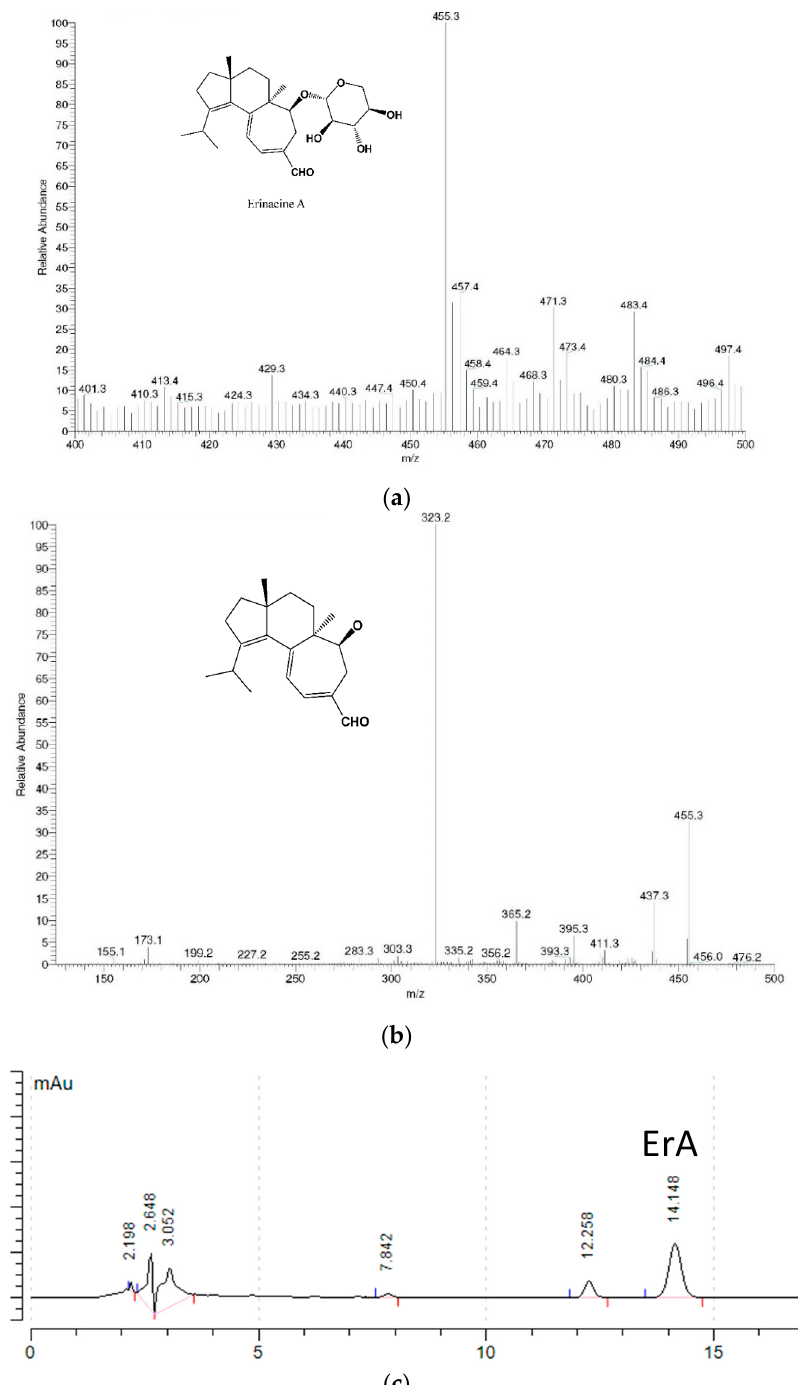
Figure 7. Analysis and identification of ErA using: ( a ) ESI Mass for ErA at m/z: 455.3 [M+Na] + , ( b ) tandem MS/MS for ErA fragment at m/z 323.2 and ( c ) HPLC analysis of the mycelia extract.